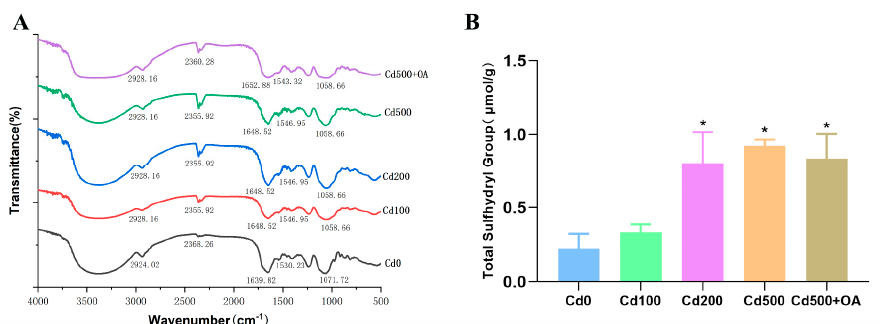
Figure 6. ( A ) FTIR spectroscopic analysis of EPSs produced by B. cepacia after being exposed to 0, 100, 200, and 500 mg/L of Cd and 2 mmol/L of OA. ( B ) The content of total sulfhydryl group in EPSs. * p < 0.05 versus control group.